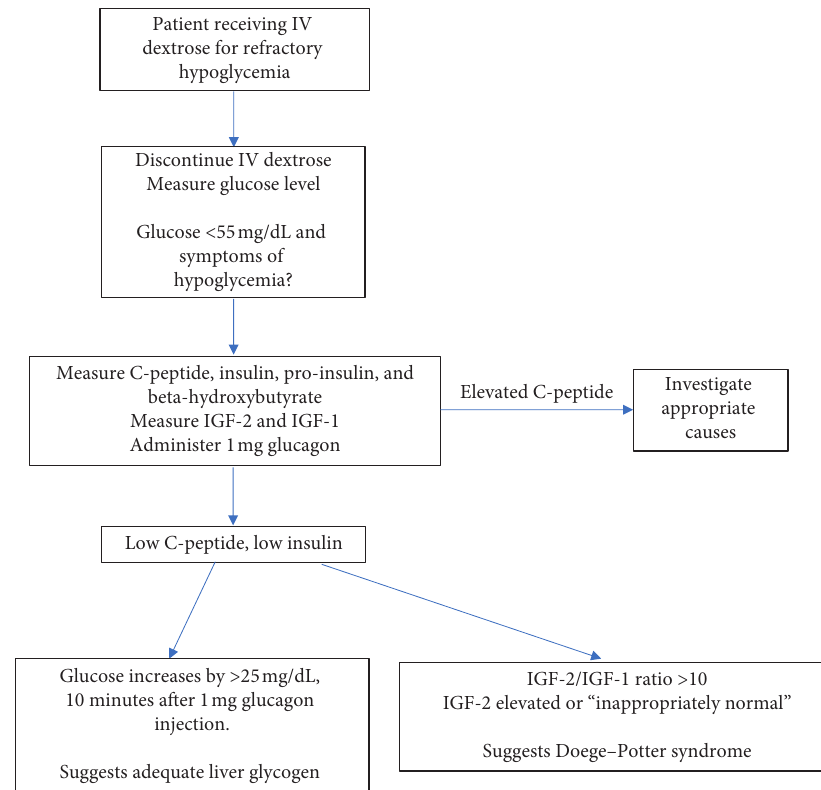
Figure 2: Clinical workup of Doege–Potter